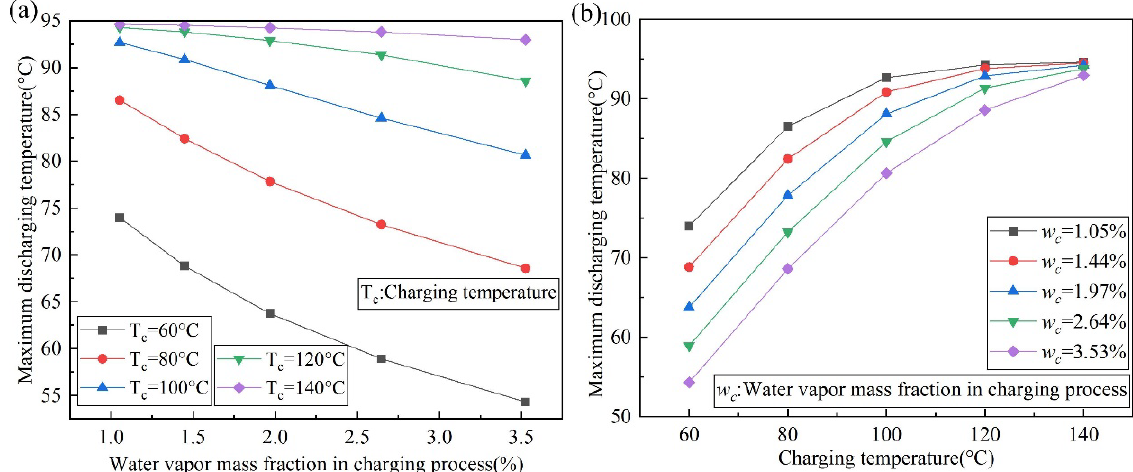
Figure 13. Change of maximum discharging temperature with ( a ) mass fraction of water vapor in the air and ( b ) charging temperature.